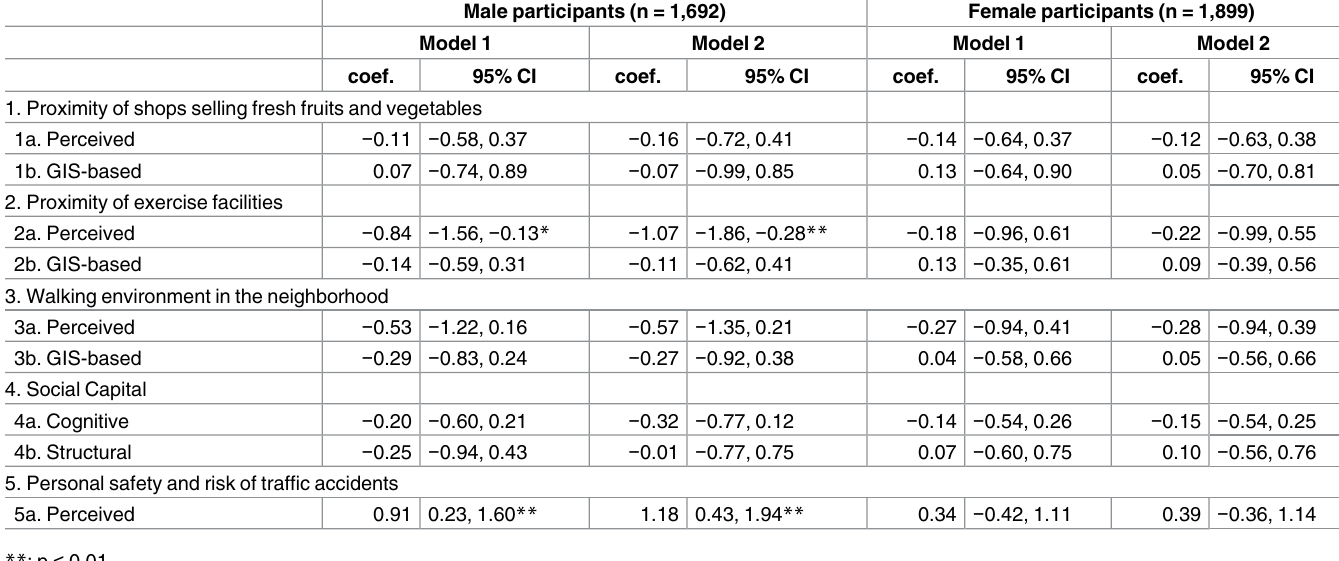
Table 4. Sensitivity analysis restricted to those participants who had resided in their current location for (cid:21) 10 yearsin Chita peninsula, Aichi Pre- fecture,